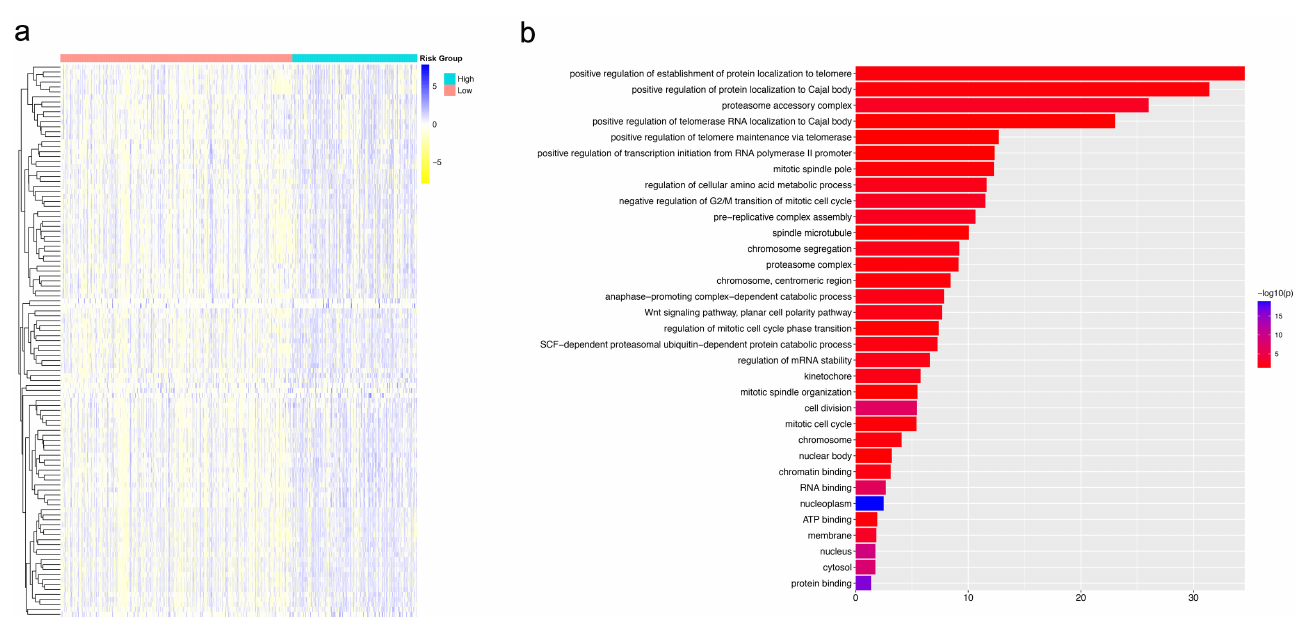
Figure 6. ( a ) Heatmap of the expression profile difference between the CNAB11-high group and the CNAB11-low group. ( b ) Gene ontology analysis between the CNAB11-high group and the CNAB11-low